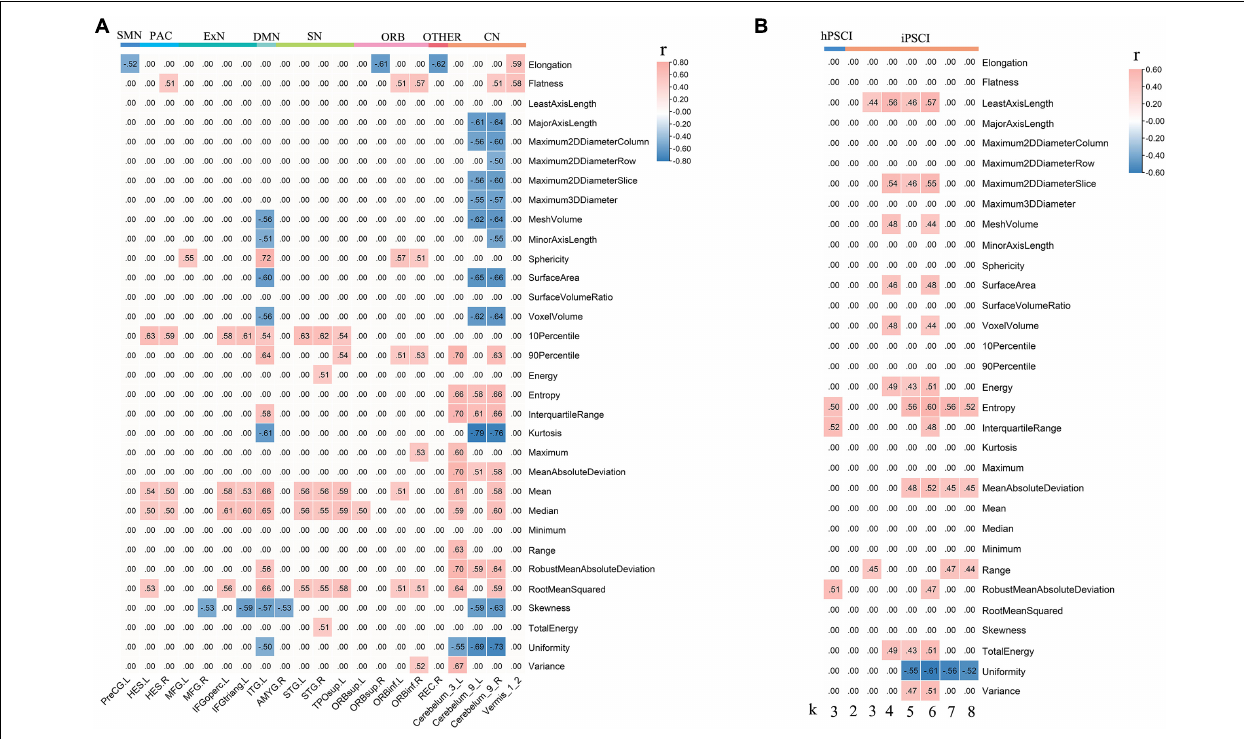
FIGURE 4 | The correlation between decreased FCs linked to CAU_L, φ norm ( k ), and radiomic features. (A) Decreased local connections were correlated with radiomic features in hPSCI. (B) φ norm ( k ) was correlated with radiomic features in hPSCI and iPSCI. CAU_L, left caudate; hPSCI, hemorrhagic post-stroke cognitive impairment; hPSCI, infarct post-stroke cognitive impairment; ORB, orbitofrontal cortex; SN, salience network; DMN, default-mode network; ExN, external frontoparietal network; PAC, primary auditory cortex; VN, visual network; SMN, sensorimotor network; CN, cerebellum network; FC, functional